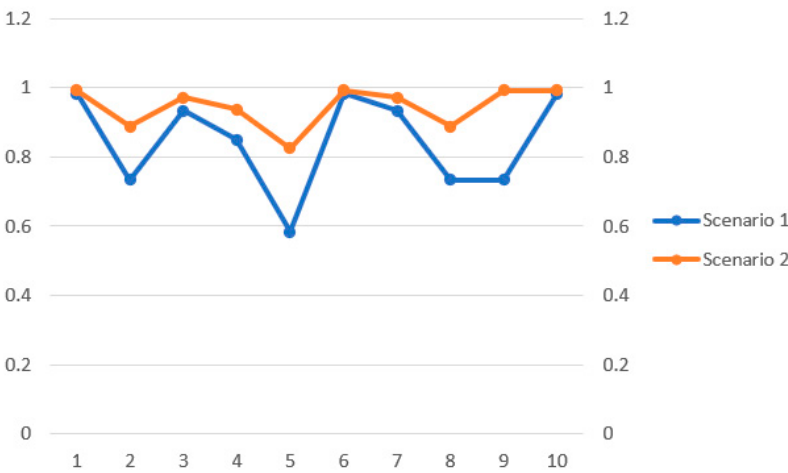
Figure 11. Correlations of each test against the original ranking for scenarios 1 and 2.